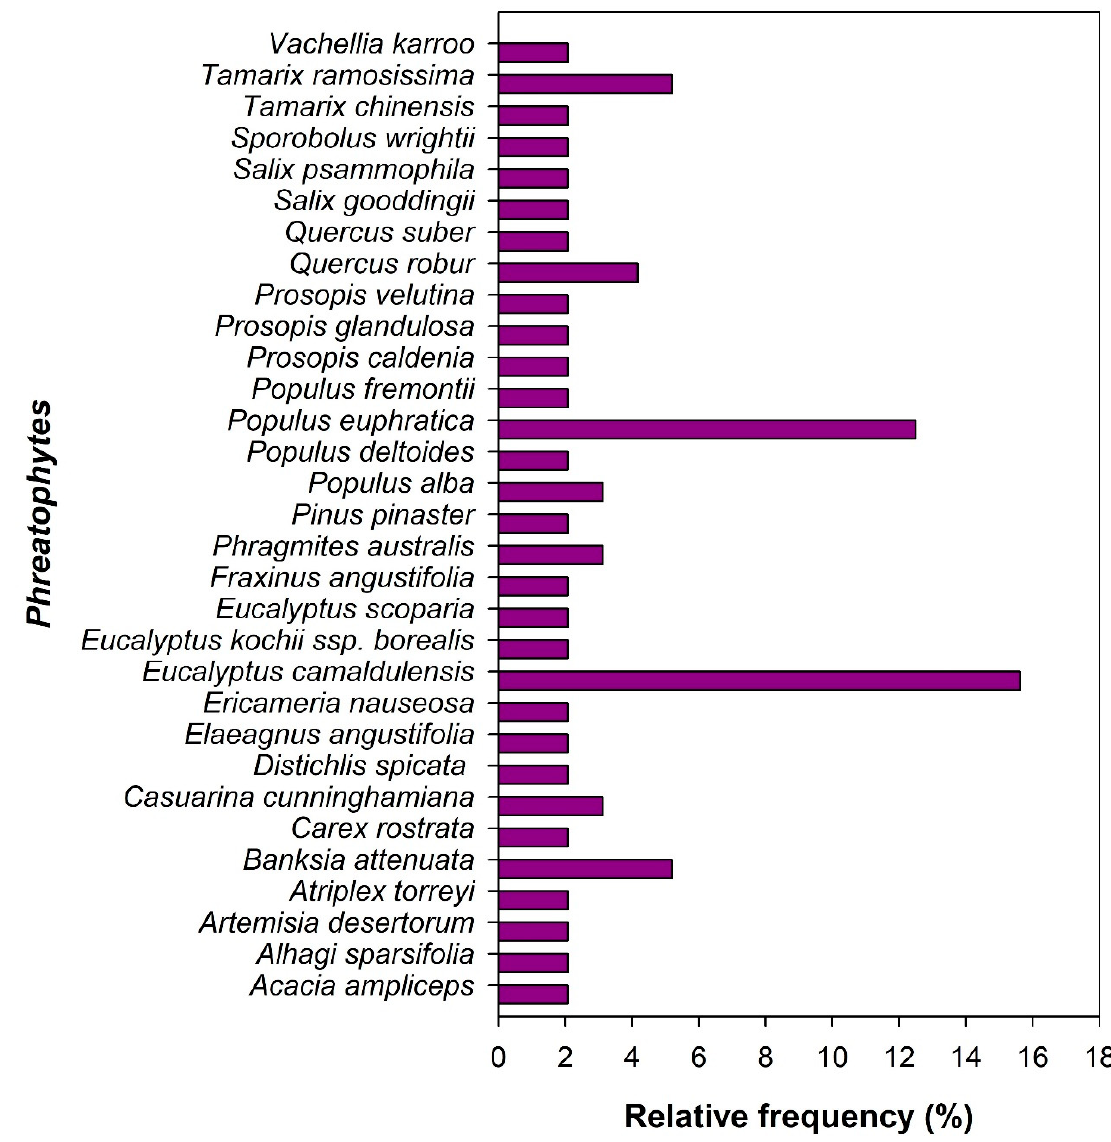
Figure 4. Dominant phreatophytes mentioned in the reviewed articles published between 1988 to 2022.